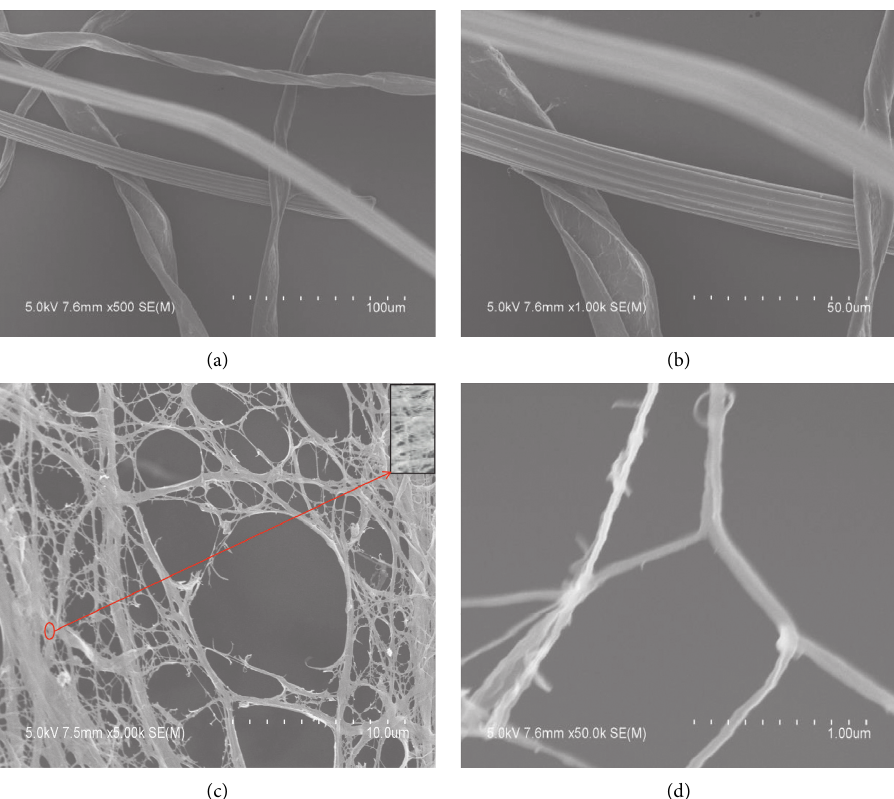
Figure 6: SEM images of the freeze-dried materials. (a) Cotton cellulose, (b) enlarged image from (a), (c) MFC, and (d) enlarged image from (c).